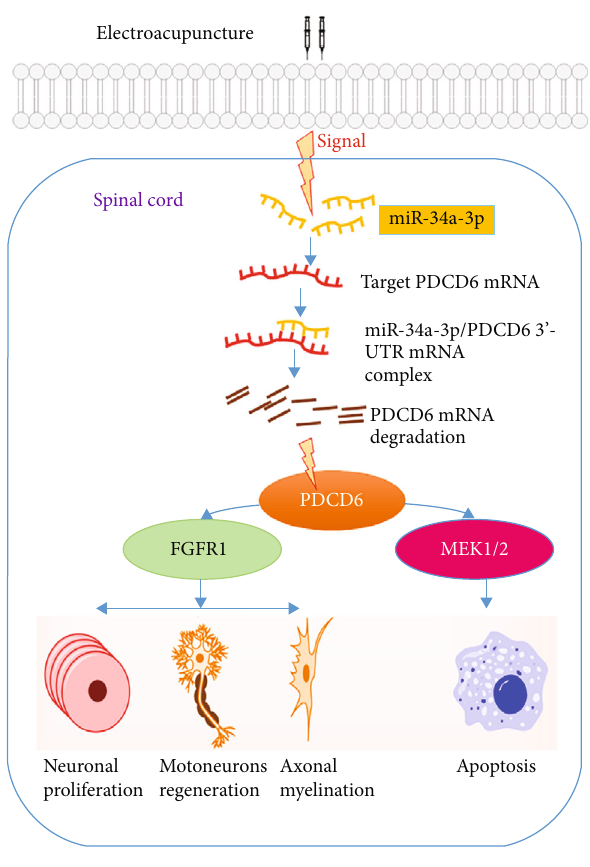
Figure 7: Mechanism of the e ff ect of EA on the miR-34a-3p/ PDCD6 axis in